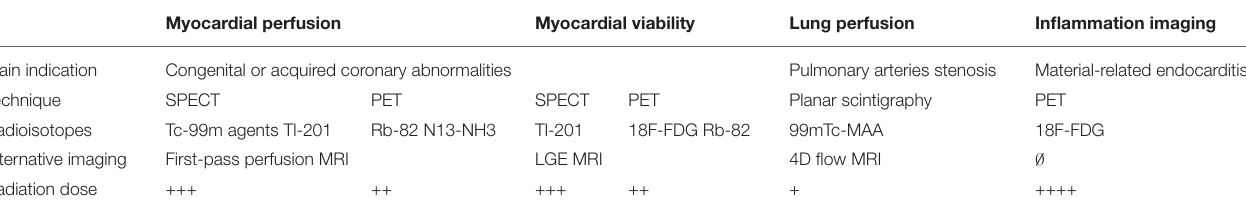
TABLE 2 | Characteristics of most relevant nuclear imaging applications in pediatric cardiology. Myocardial